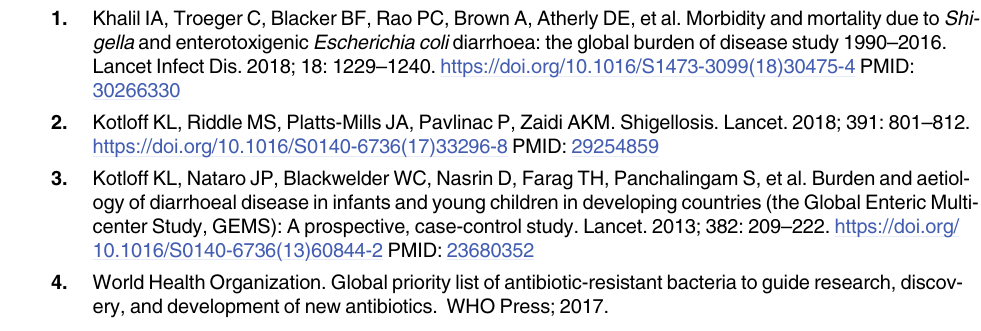
S1 Table. Differentially expressed S. sonnei genes and pathogen pathway enrichment anal- ysis in vivo . S2 Table. Differentially expressed zebrafish genes and host pathway enrichment analysis in response to S. sonnei infection. S3 Table. Bacterial strains used in this study. S4 Table. Primers and morpholinos used in this